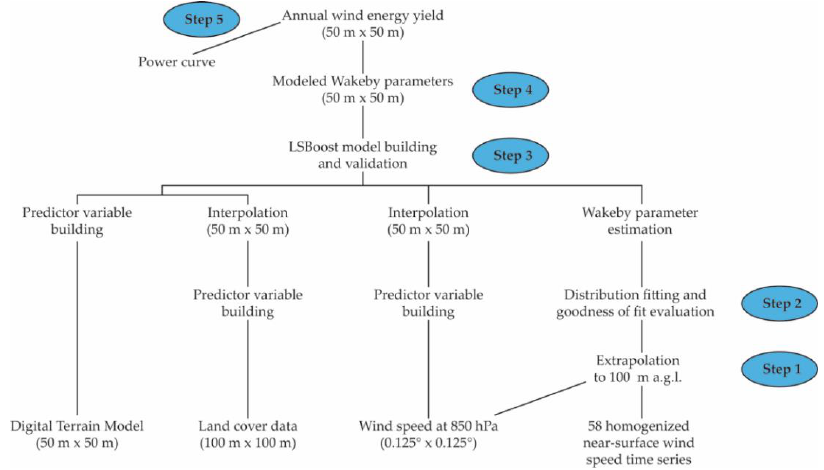
Figure 3. Schematic representation of the workflow applied to obtain annual wind energy yield ( AEY ).